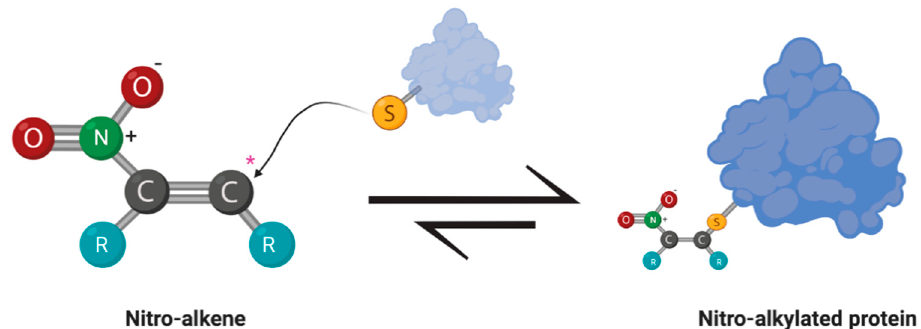
Figure 2. Michael addition between an electrophilic nitroalkene and a nucleophilic thiol group of a protein. The nitro moiety creates an electrophilic carbon (*) susceptible to nucleophilic attack by the thiol group of an amino acid residue, such as cysteine. Reactions with soft electrophiles create a reversible adduct that can alter the cell signaling activity or enzymatic activity of the effected protein.